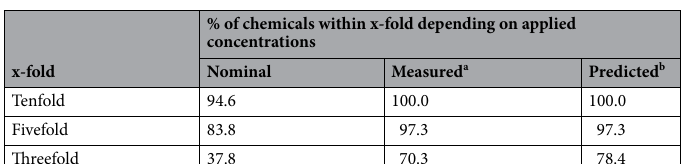
% of chemicals within x-fold depending on applied